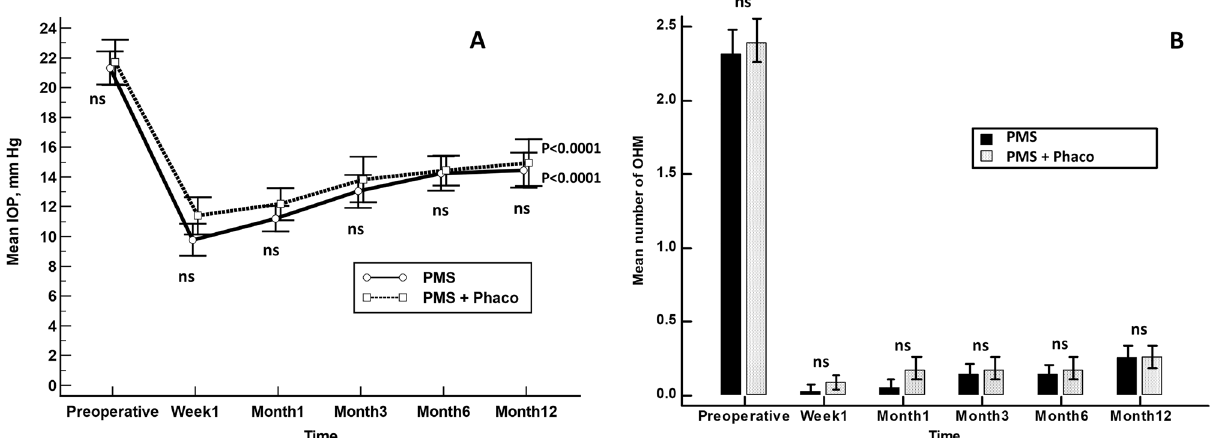
Figure 2. A comparison of mean intraocular pressure (IOP) ( A ) and number of ocular hypotensive medications ( B ) between PMS and PMS + Phaco groups. Statistical significance between groups was determined using the Mann–Whitney U test. p < 0.0001 as compared to baseline (repeated measures ANOVA and the Greenhouse–Geisser correction). IOP intraocular pressure, OHM ocular hypotensive medications, ns not significant.